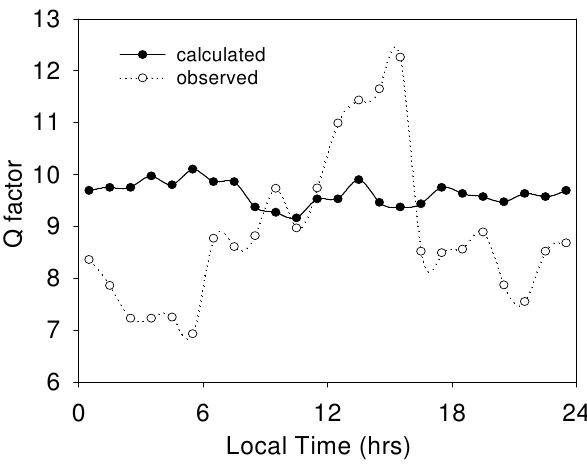
Fig. 7. Comparison of observed and calculated (Eq. 4) qual- ity factor (Q) for second mode ( n =2) Schumann resonance fre- quency. Observed quality factor is obtained from the recorded data as Q= Re(f n ) /[2. Im(f n ) ], the Im(f n ) is the half width of the spec- tral